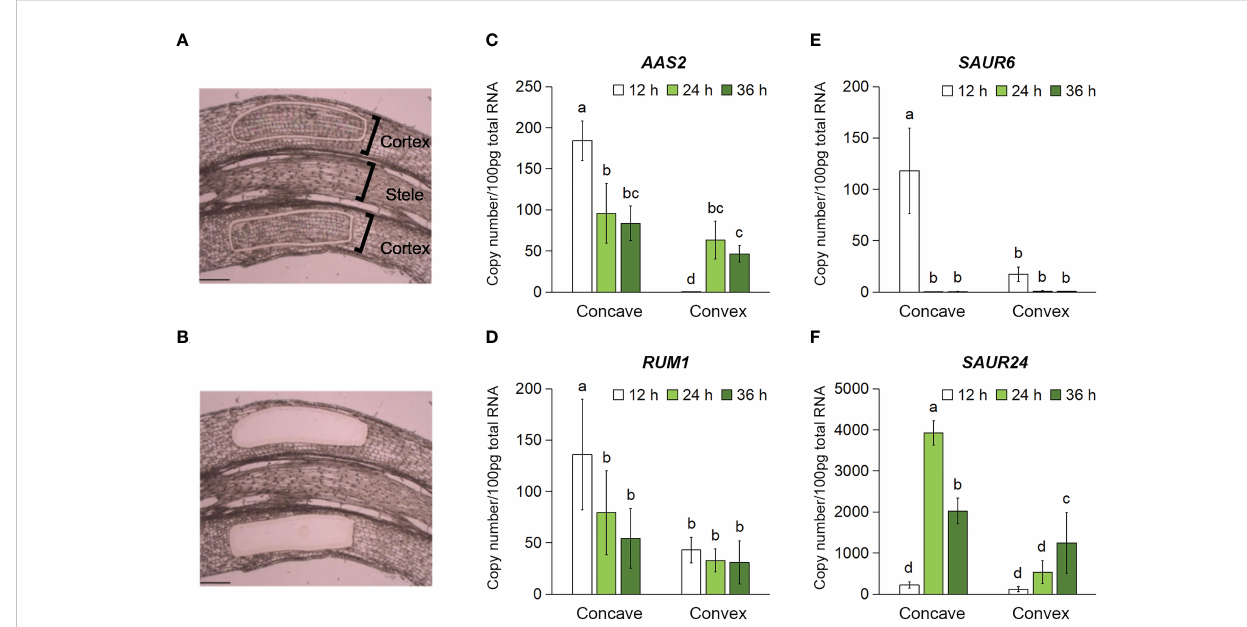
FIGURE 6 Time-course expression levels of the auxin-responsive genes in the cortex on the concave and convex sides in the bent region (0 mm ± 2 mm) of the gravity-stimulated nodal roots of Z. nicaraguensis . Pictures of the longitudinal section of the nodal roots before (A) and after (B) the isolation of the cortex using laser microdissection. Scale bar = 300 µm. Copy numbers of the transcripts of AAS2 (C) , RUM1 (D) , SAUR6 (E) , and SAUR24 (F) in the cortex on the concave and convex sides at 12, 24, and 36 h after the gravistimulation treatment. Signi fi cant differences between the concave and convex sides at each time point are denoted with different lowercase letters ( p < 0.05, one-way ANOVA, followed by LSD test for multiple comparisons). Values are mean ± SD ( n = 3 to 5).